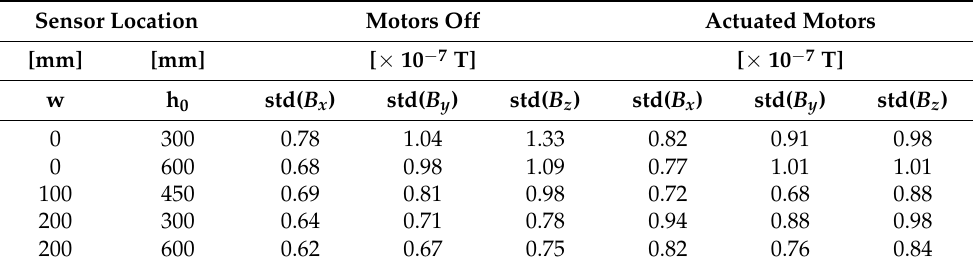
Table 3. Measuring device mechanical characteristics. Standard deviations std( · ) of component